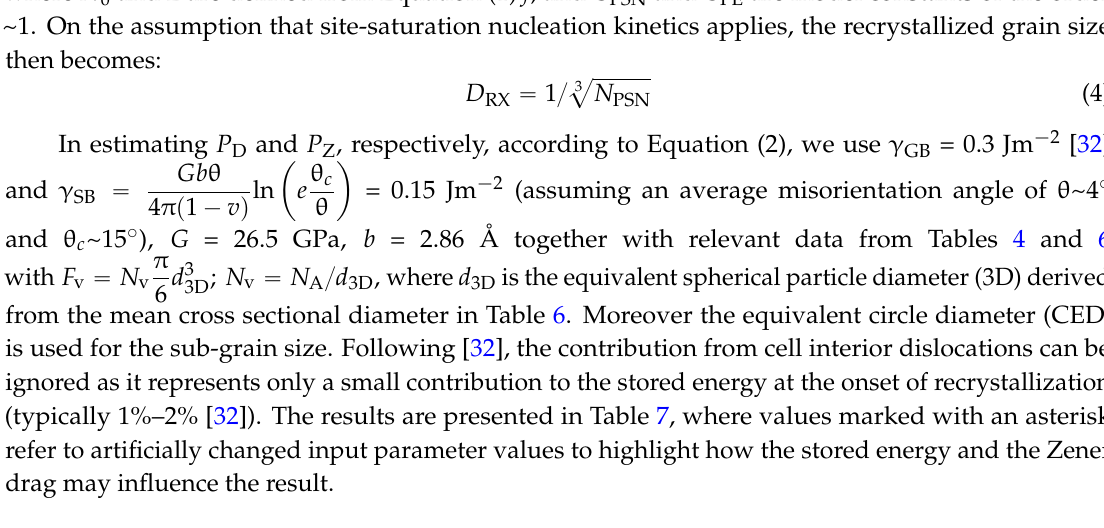
Table 7. Estimated values for initial ( t = 0) stored energy, P D , and Zener drag, P Z , for C2-2 and C2-3 and resulting calculated grain sizes (assuming PSN only; see text below) for annealing at 400 ˝ C and 350 ˝ C, for 10 5 s, respectively, after different strains (based on Equations (3) and (4)). Alloys True Strain ε δ CED ( µ m) P D (MPa) P Z